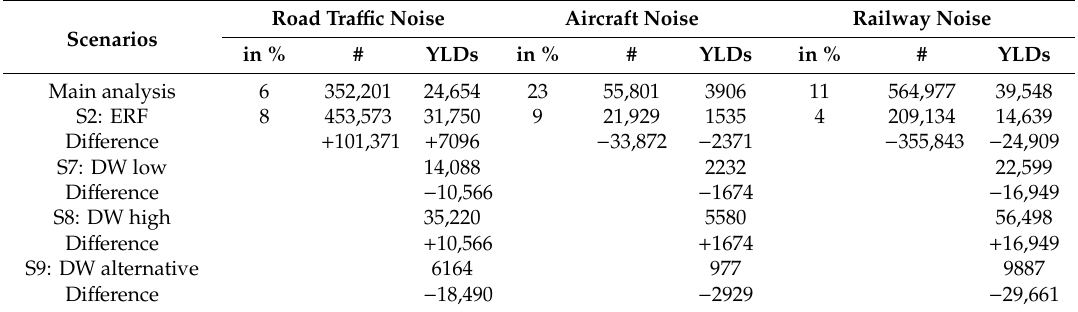
Table 12. Sensitivity analysis of the burden of disease due to sleep disturbance attributable to tra ffi c noise in Germany,